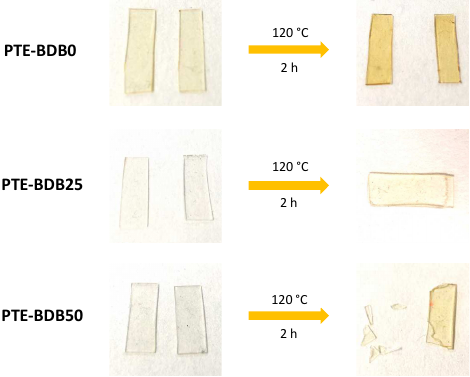
Figure 4. Healing behavior of PTE-BDB samples at 120 °C for 2 h.